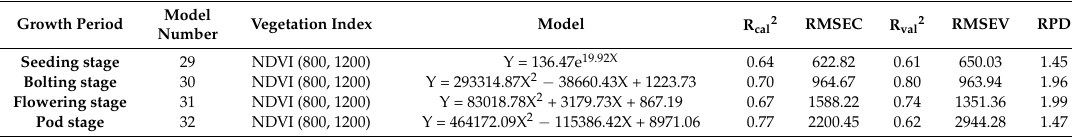
Table 6. Regression modeling analysis between NDVI (800, 1200) and